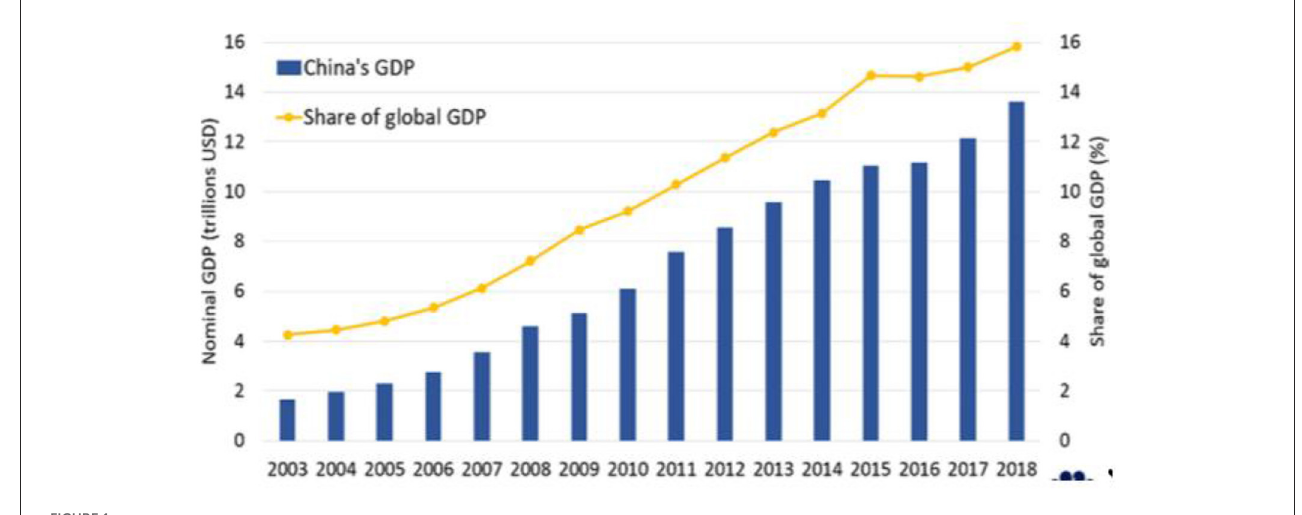
FIGURE1 GDP growth in China and China’s share of the global economy. Source: World Bank,